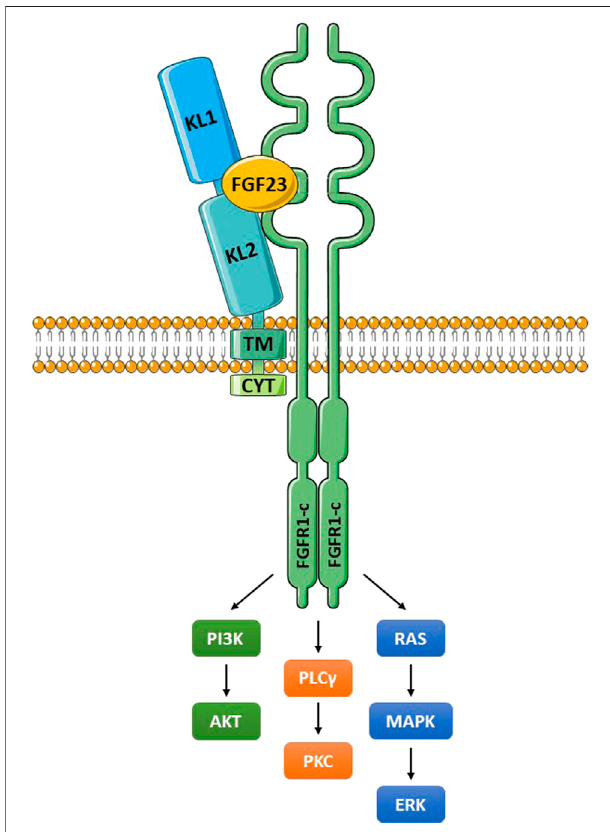
FIGURE 2 | The Klotho/FGFR/FGF23 signaling complex. Klotho interacts with a FGFR (frequently FGFR1c) through an extension of its KL2 domain. FGF23 fi ts into a groove formed by components of KL1, KL2 and the FGFR. The membrane-bound and soluble Klotho forms (KL1/KL2 domains) can both bind to FGFR1c and function as coreceptors (Chen G, et al., 2018). These molecular interactions create a high af fi nity binding site for FGF23. The activated FGFR signals through multiple pathways as illustrated, and outlined in the text. Abbreviations: ERK, extracellular signal-regulated kinase; FGF23, fi broblast growth factor 23; FGFR1-c, FGF receptor 1c; MAPK, mitogen-activated protein kinase; PI3K, phosphoinositide 3-kinase; PKC, protein kinase C; PLC γ , phospholipase C γ